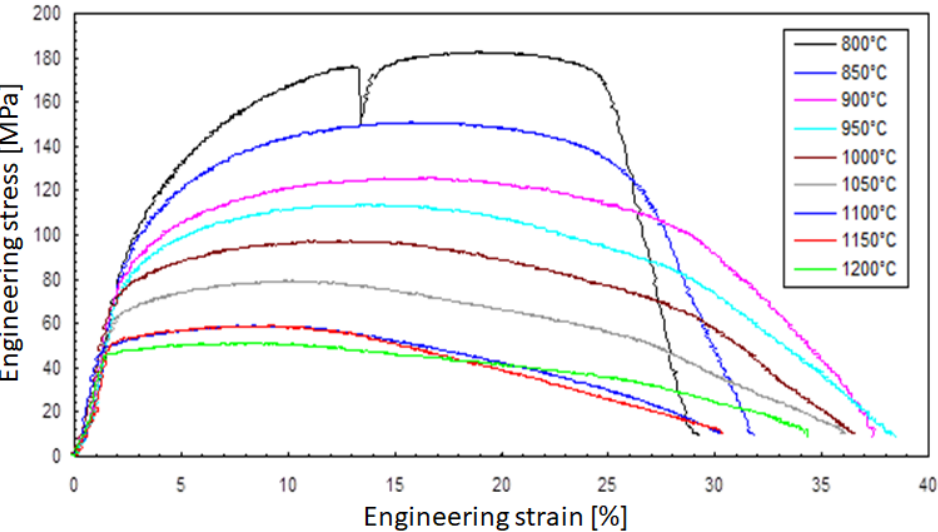
Figure 11. Stress/elongation curves for a laboratory ingot of Fe-22Mn-0.6C TWIP steel for tempera- tures in the range 800–1200 ◦ C. The steel had no V or P and contained less than 20 ppm wt. of Al. The strain rate was 1 × 10 − 2 s − 1 .